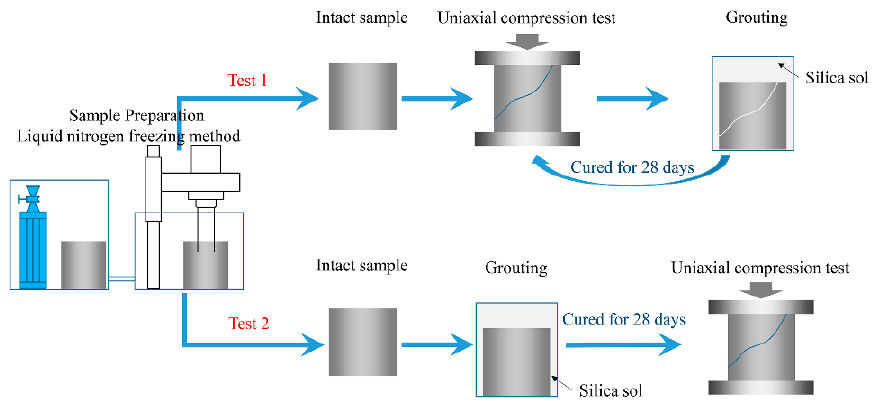
Figure 8. Flow chart for the uniaxial compression tests for mechanical properties.